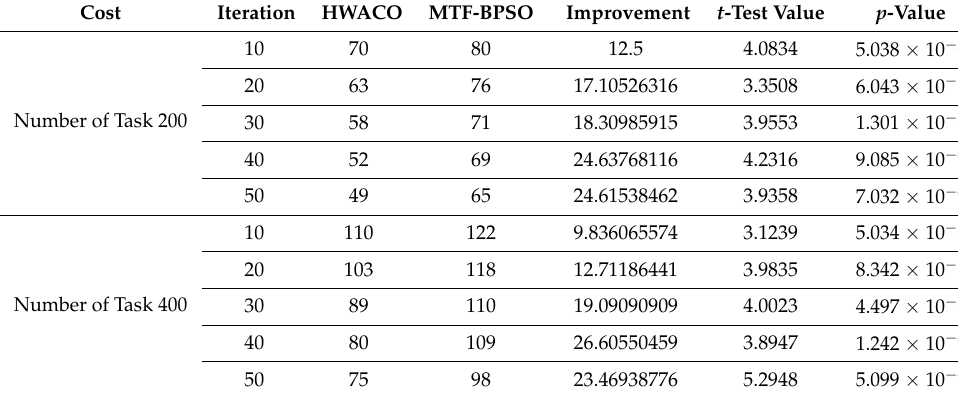
Table 10. t -Test for cost between HWACO and MTF-BPSO.